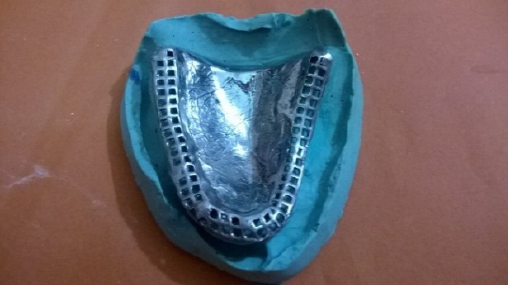
Figure 5. Cast metal base adapted on secondary cast. The part of metal base overlying alveolar crest region contains mesh pattern with small square perforations to improve the bonding of wax and heat cure acrylic with metal plate in bite templates and final prosthesis respectively.